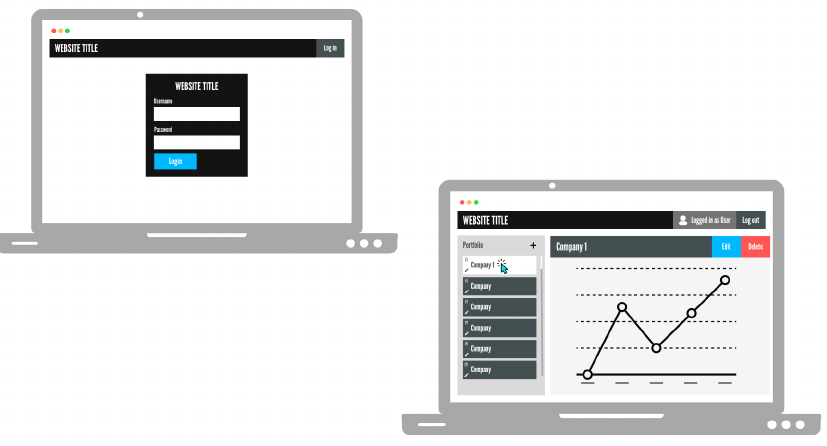
Figure 9. User Interface (UI) wireframe diagram.